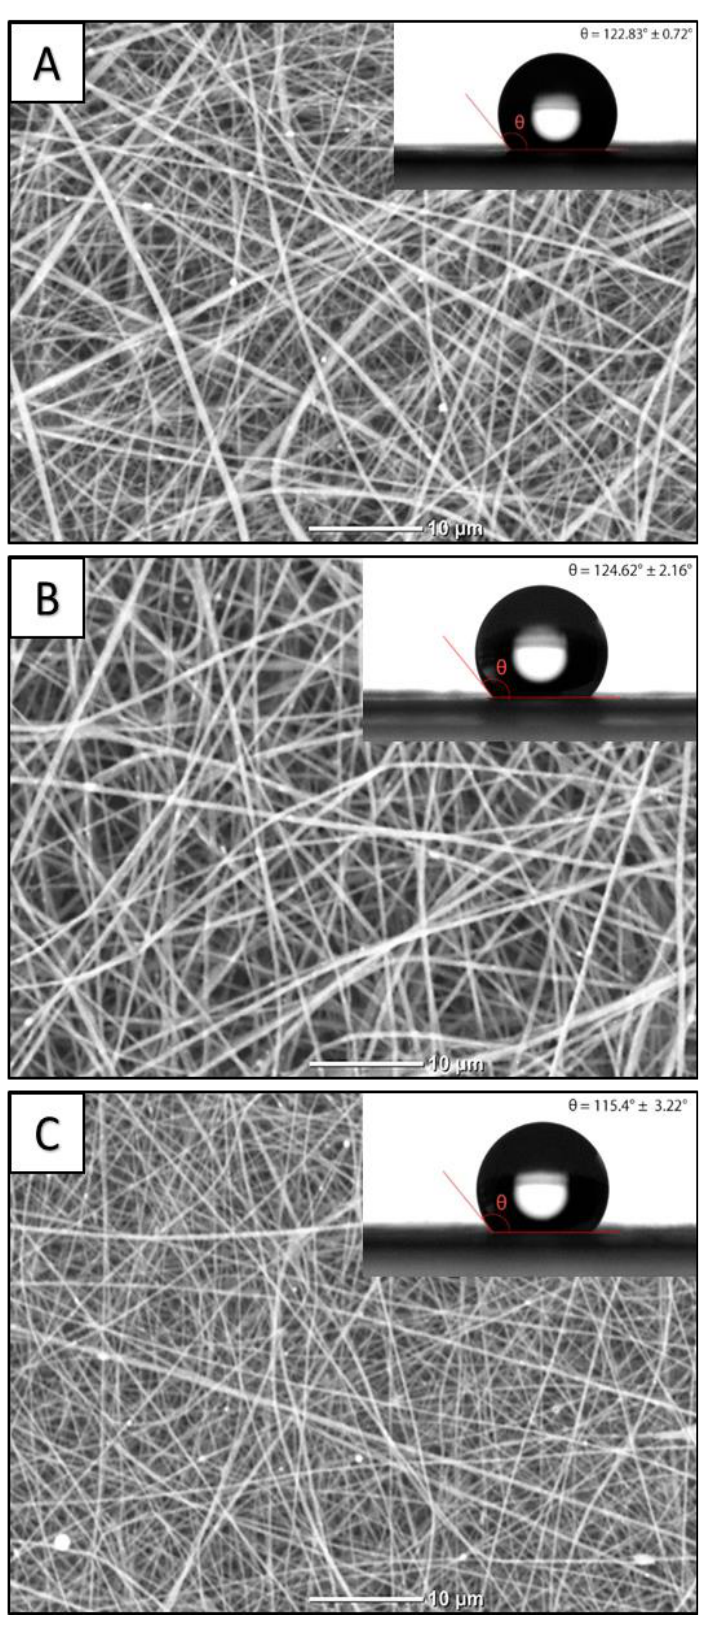
Figure 1. SEM images and water contact angles of VDF-TeFE/ZnO membranes with various PVP content: ( A ) 0 wt%; ( B ) 10 wt%; ( C ) 40 wt%. content: ( A ) 0 wt%; ( B ) 10 wt%; ( C ) 40